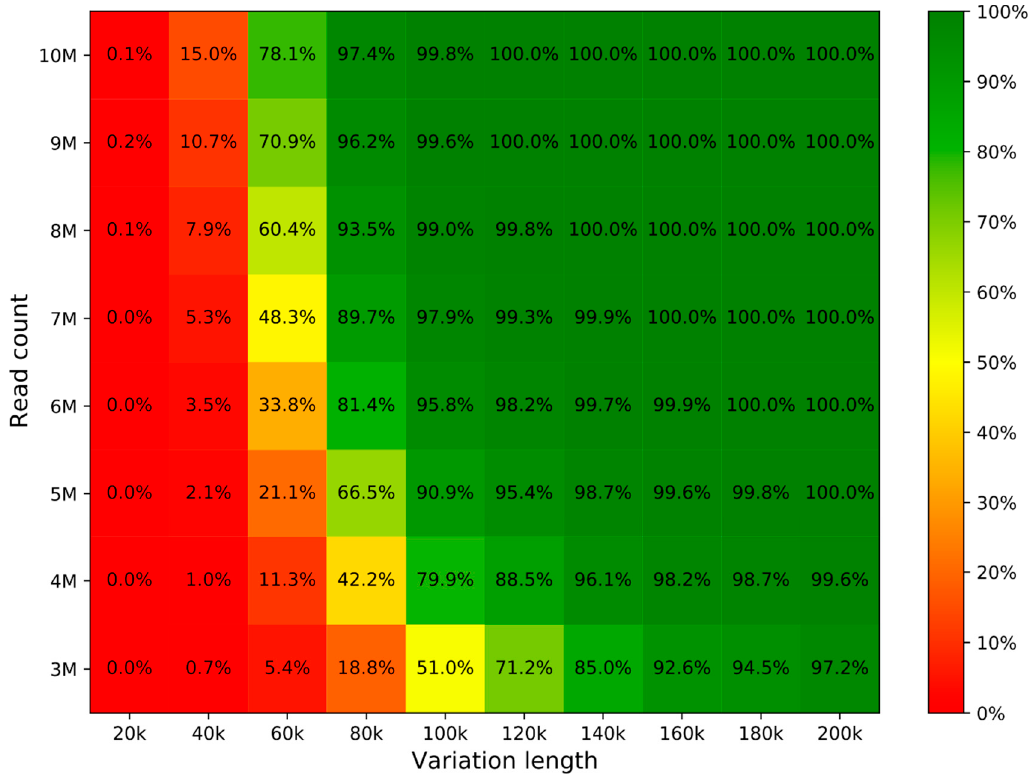
Figure 3. Prediction accuracy computed with in silico analysis based on the length of variation and read count. Each cell number is generated from 8300 simulations (100 randomly generated aberrations; 83 samples).